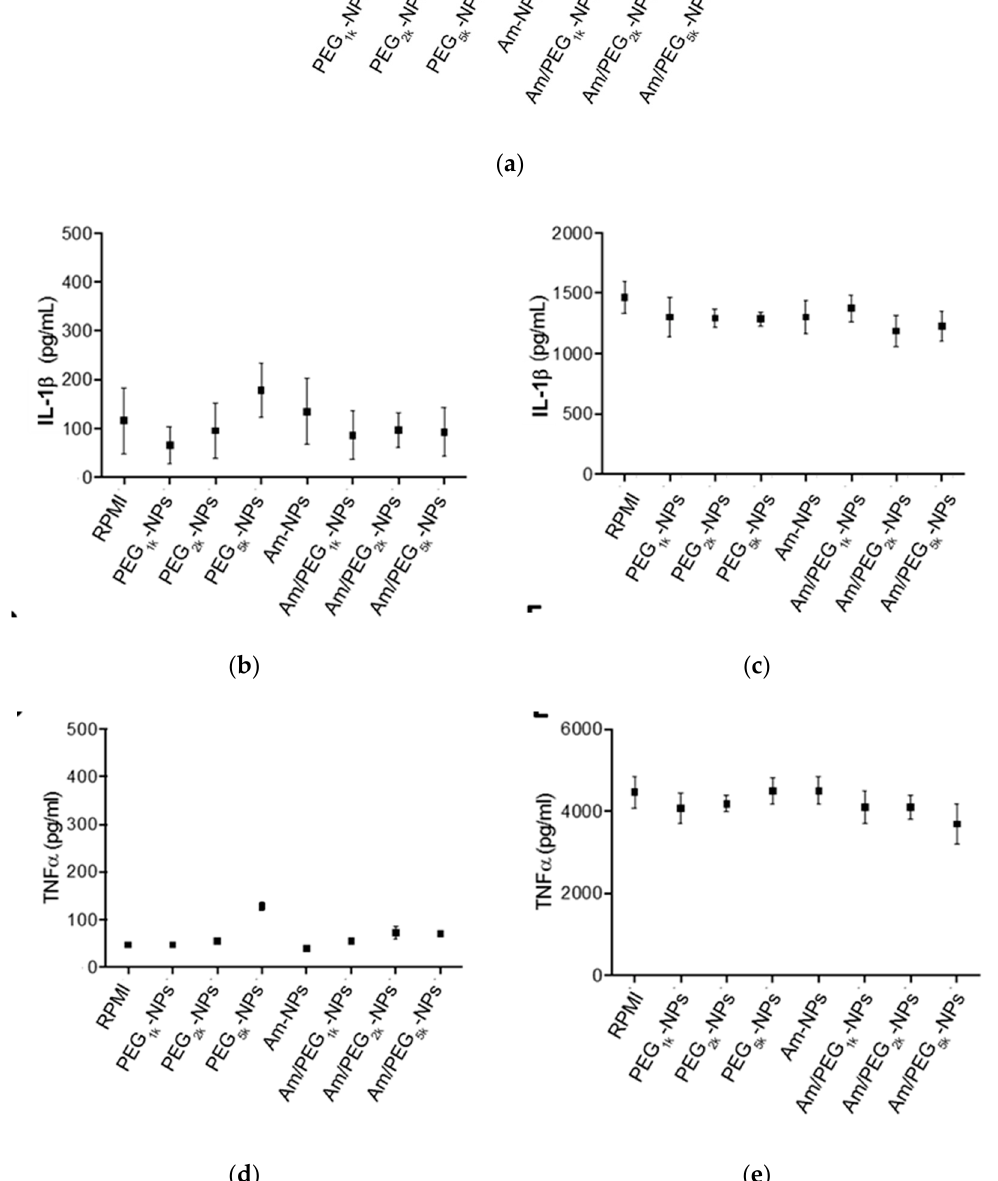
Figure 7. Uptake and inflammatory response to NPs by human monocytes. ( a ) Quantification of NPs taken up by monocytes after 2 h incubation. Production of IL-1 β ( b , c ) and TNF α ( d , e ) by human monocytes after 24 h of incubation with NPs as assessed by an ELISA kit. Panels ( c , e ) refer to LPS stimulated monocytes. Results represent mean ± SEM, n = 2.